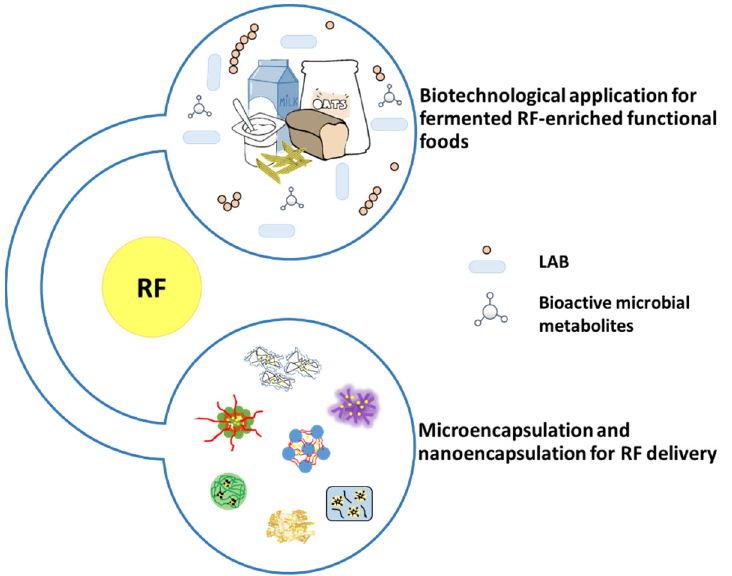
Figure 9. RF in functional food and encapsulation products.